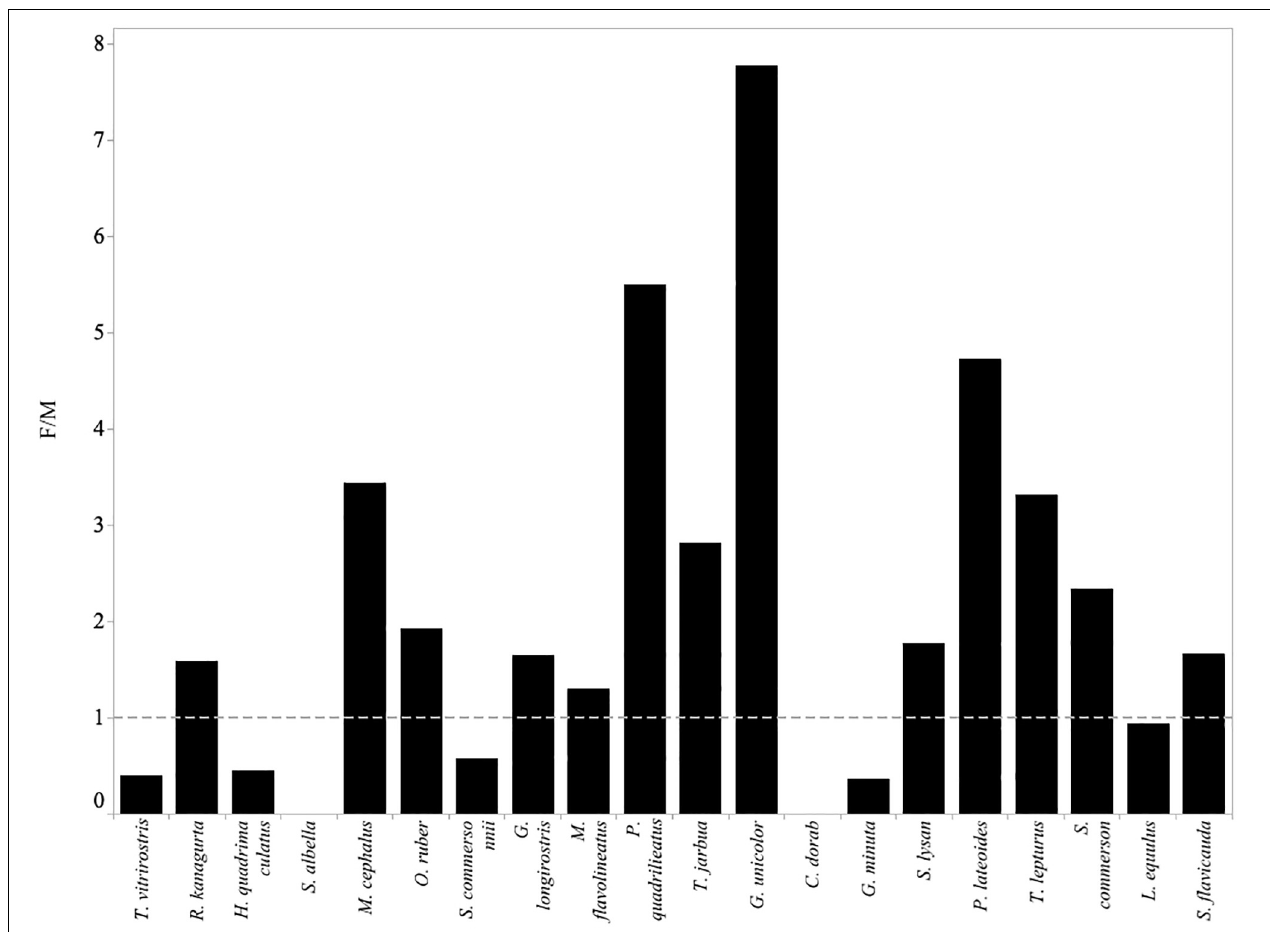
FIGURE 7 | Fishing mortality (F) relative to natural mortality (M) for each of the twenty most abundant species in the small-scale fisheries catches of Menabe. Values above 1 (indicated by the gray dotted line) imply that the species is experiencing